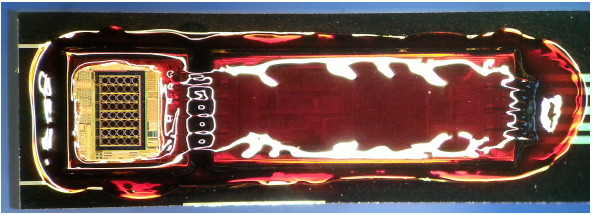
Figure 24. Photo of the sensor module with the wider silicon chip